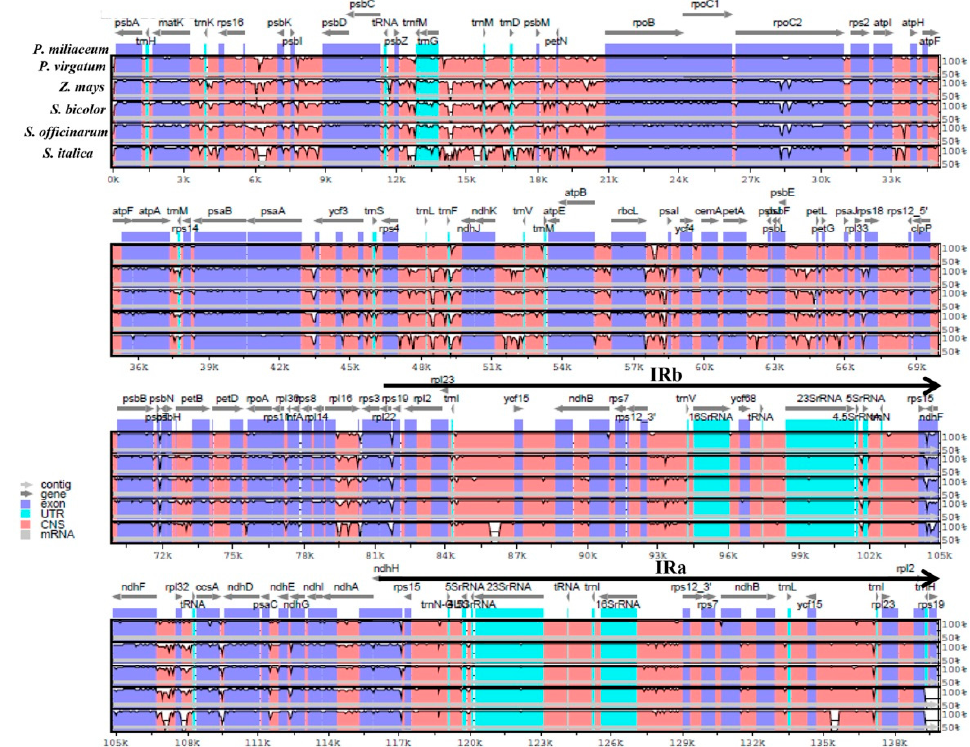
Figure 3. Percent identity analysis for the comparison of six Panicoideae chloroplast genomes using mVISTA program. The top line displays genes in order with arrows. Sequence similarity of aligned regions between broomcorn millet and the other five species is shown in the direction of horizontal level implying average percent identity between 50–100% (shown on y -axis of graph). The x -axis is considered the coordinate in the cp genome.